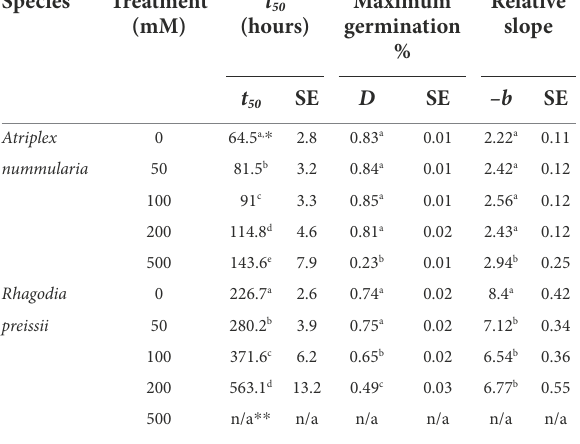
TABLE 5 Salinity experiment 2A: influence of salinity level on seed germination of A. nummularia and R. preissii at five different salinity levels, expressed by the estimated parameters and associated standard errors (SE) from the log-logistic model (1) applied to the